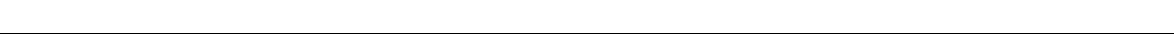
Figure 4 | Seb1 point mutations cause transcriptional read-through genome-wide. ( a ) Analysis of Seb1-HA recruitment to the rps401 gene by ChIP-qPCR. Positions of primers used are shown in the schematics above. Seb1-WTwas depleted in thiamine-containing media for 24h. Error bars indicate the standard error of biological duplicates. ( b ) Left: same as a but a phosphorylation-independent antibody against the Pol II-CTD was used (8WG16). Right: Same as a but signal was normalized to Pol II levels (shown on the left). ( c ) Median mapped reads determined by RNA-Seq in the indicated point mutants were centred on the PAS. All curves are normalized to the same starting value using the same subset of genes as in Fig. 1c. ( d ) Read-through of the different point mutants was determined by dividing mapped reads in the window PAS ± 50nt by the read count within the gene-body ( n ¼ 5,119). The log2 fold change in read-through as compared to WT is shown. The significance of the overall difference between WT and each mutant was determined by the Wilcoxon–Mann–Whitney test and is indicated below each box. ( e ) Northern blot showing different transcripts derived from the rps401 gene in the indicated mutants (cells were grown as in a ). Arrows on the right mark individual transcripts and the position of the probe used relative to the gene is indicated in the schematics above. ( f ) Venn diagram depicting the overlap between genes that show significantly ( P o 0.05) more read-through than WT calculated as in d and determined by the Kruskal–Wallis test for the indicated strains. Protein-coding (top, n ¼ 4,105) and non-coding (bottom, n ¼ 1,013) genes are shown separately. No genes could be found in the strains S22D-K25E and S492A that have significantly more read-through than WT. ( g ) The log2 fold read-through was calculated as in d for the same subset of genes as in Fig. 1c but here, all genes were split into two groups, those containing crosslinks detectable by PAR-CLIP at 250nt ± PAS ( n ¼ 1,536) and those that do not ( n ¼ 2,692). The significance of the difference between the two groups was calculated for each mutant as in d . In box plots in this figure, the centre line is the median, the box limits are from the second to the third quartile (so 25% to 75% of the data points), and the whiskers extend from there to the min and max values, with outliers indicated by dots outside the